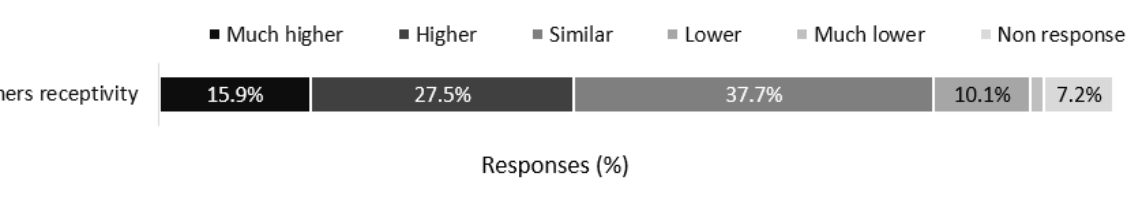
Figure 9. Respondents’ p erceptions of competition set by semifinished products and end-products made of timber coming from the windstorm that are not labeled PEFC Fair supply chain. Significant differences were found in the perceptions of competition set by the above semifinished products and end-products ( χ 2 = 50.333, p -value < 0.001). SR analysis showed